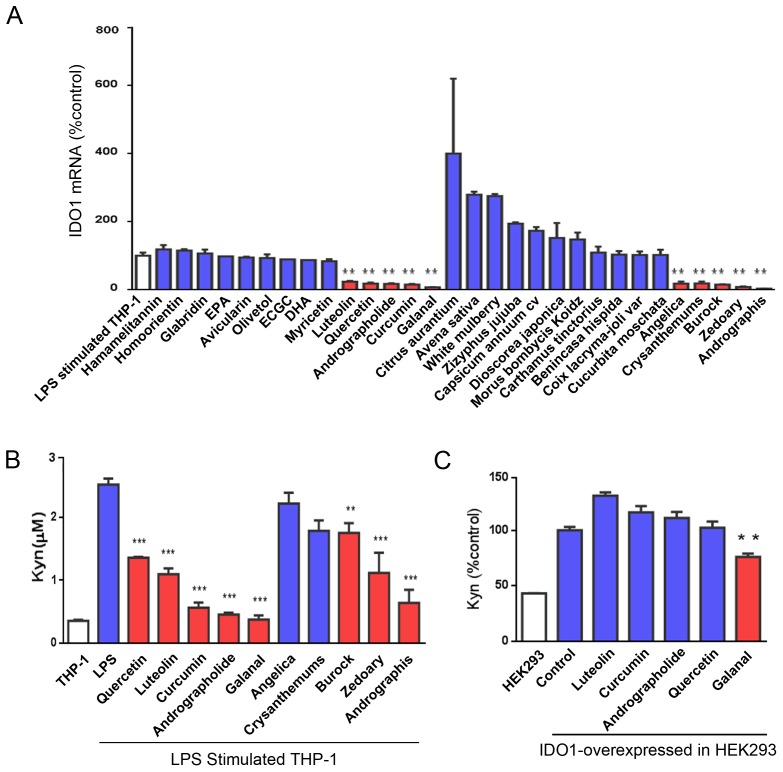
Effects of plant extracts and phytochemicals on IDO1 induction.(A) The expression of IDO1 mRNA in LPS-stimulated THP-1 cells with and without either plant extracts or phytochemicals. THP-1 cells were incubated with LPS (50 ng/ml) and either plant extracts (30 µg/ml each) or phytochemicals (10 µM each). The levels of IDO1 mRNA were measured using RT-PCR. (B) L-Kyn formation from L-Trp in LPS-stimulated THP-1 cells with and without either plant extracts or phytochemicals. L-Kyn formed in the LPS-stimulated cells with each treatment after 24-hr incubation was measured by HPLC. (C) HEK293cells transfected with human IDO1 were incubated with galanal, curcumin, andrographolide, quercetin, or luteolin (5 µM each). The concentration of L-Kyn formed after 48-hr incubation was measured by HPLC. Data are expressed as the mean ± SD (n = 3). ***P<0.001. **P<0.01.